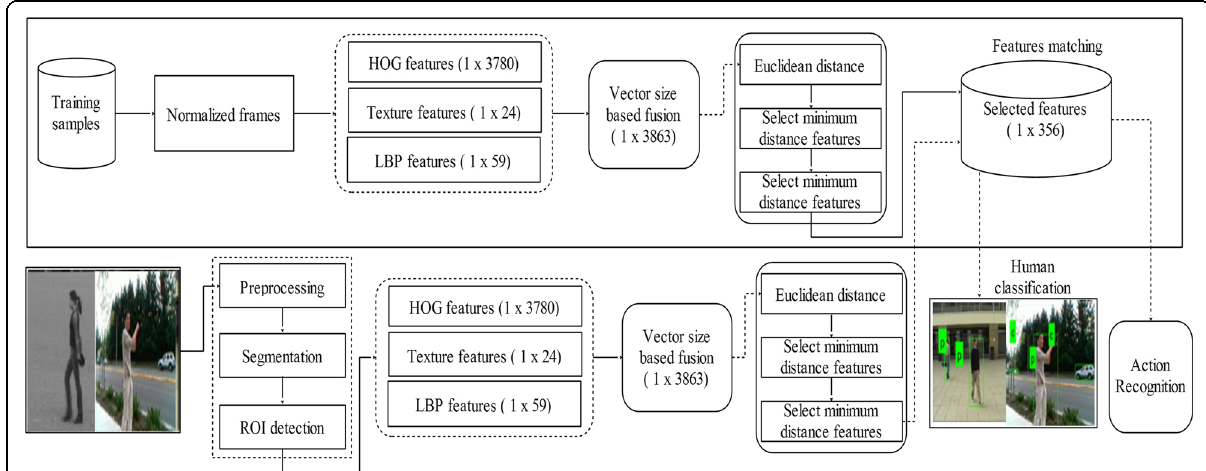
Fig. 11 Training and testing procedure using a fusion of three types of features